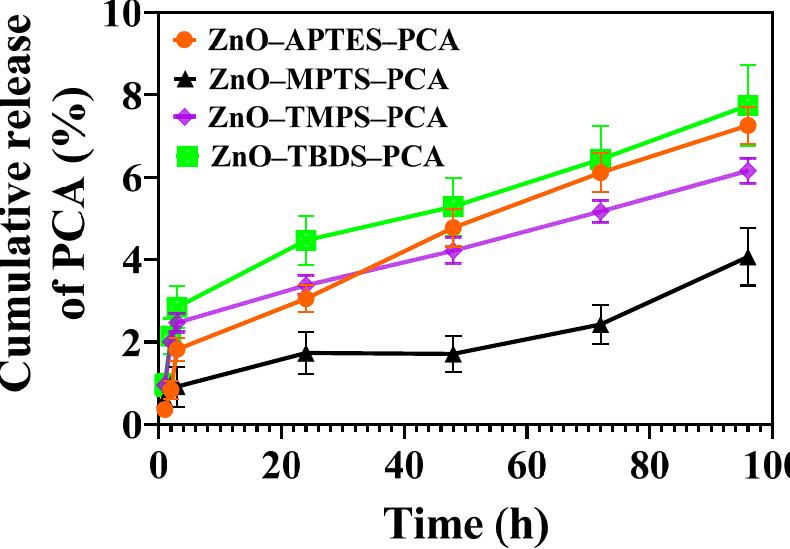
Figure 7. Release of the PCA prodrug from nanoformulations in the PBS medium (mean ± standard).